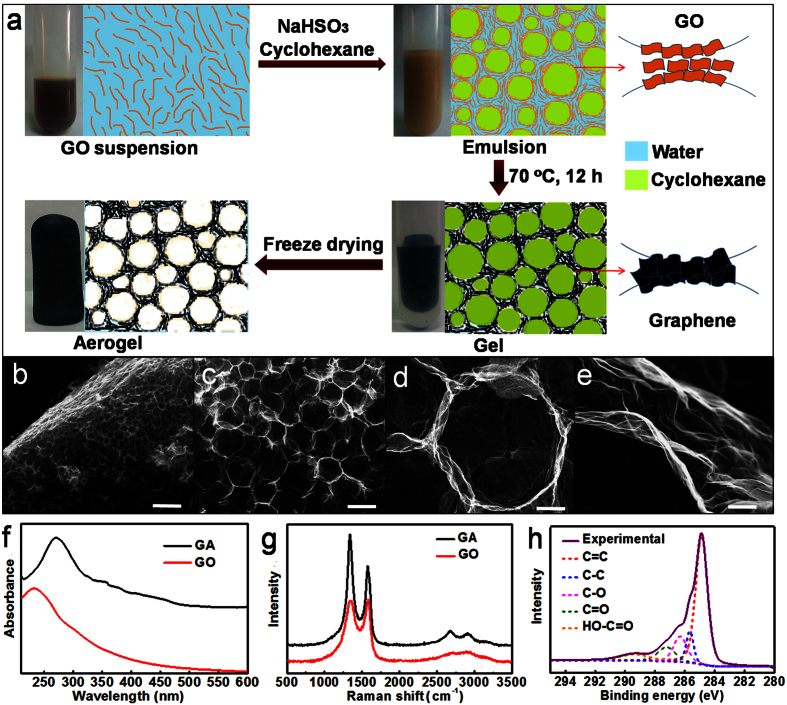
GA fabrication and characterizations.(a) Scheme illustrating the synthesis process of GA from the assembly of GO at oil-water interface and the subsequent chemical reduction. (b) Whole view of the GA derived from the emulsion with GO concentration of 2.00 mg mL−1, revealing that the bulk of aerogel is entirely composed of cellular-like pores. (c) The image shows the closely linked pores with polyhedral morphology. (d) A hexagonal pore shares the boundary with other six adjacent pores, ensuring the firm bridge of the connection. (e) The ultrathin and wrinkled wall. (f ) UV-vis spectra of the aqueous suspensions of GO and GA. (g) Raman spectra of GO and GA. (h) C 1s XPS spectra of GA. Scale bars 150 μm (b), 50 μm (c), 8 μm (d), and 500 nm (e).